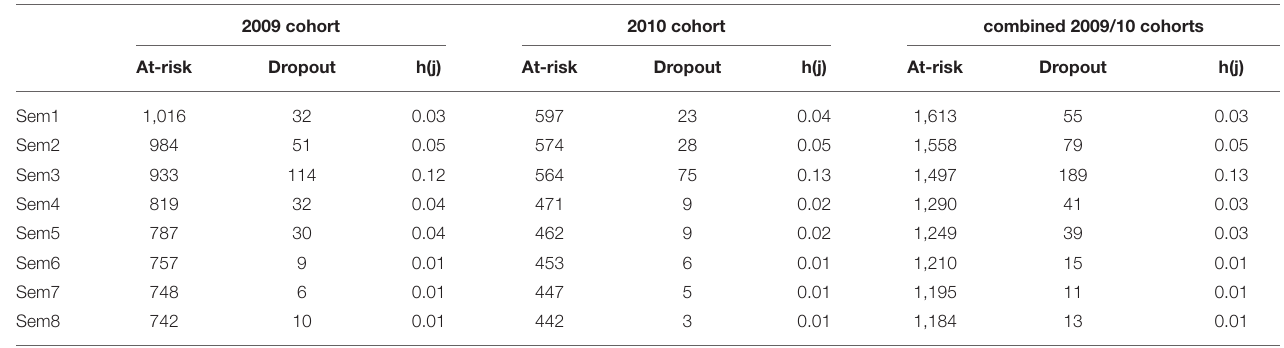
TABLE 3 | Descriptive statistics on the characteristics of dropouts across